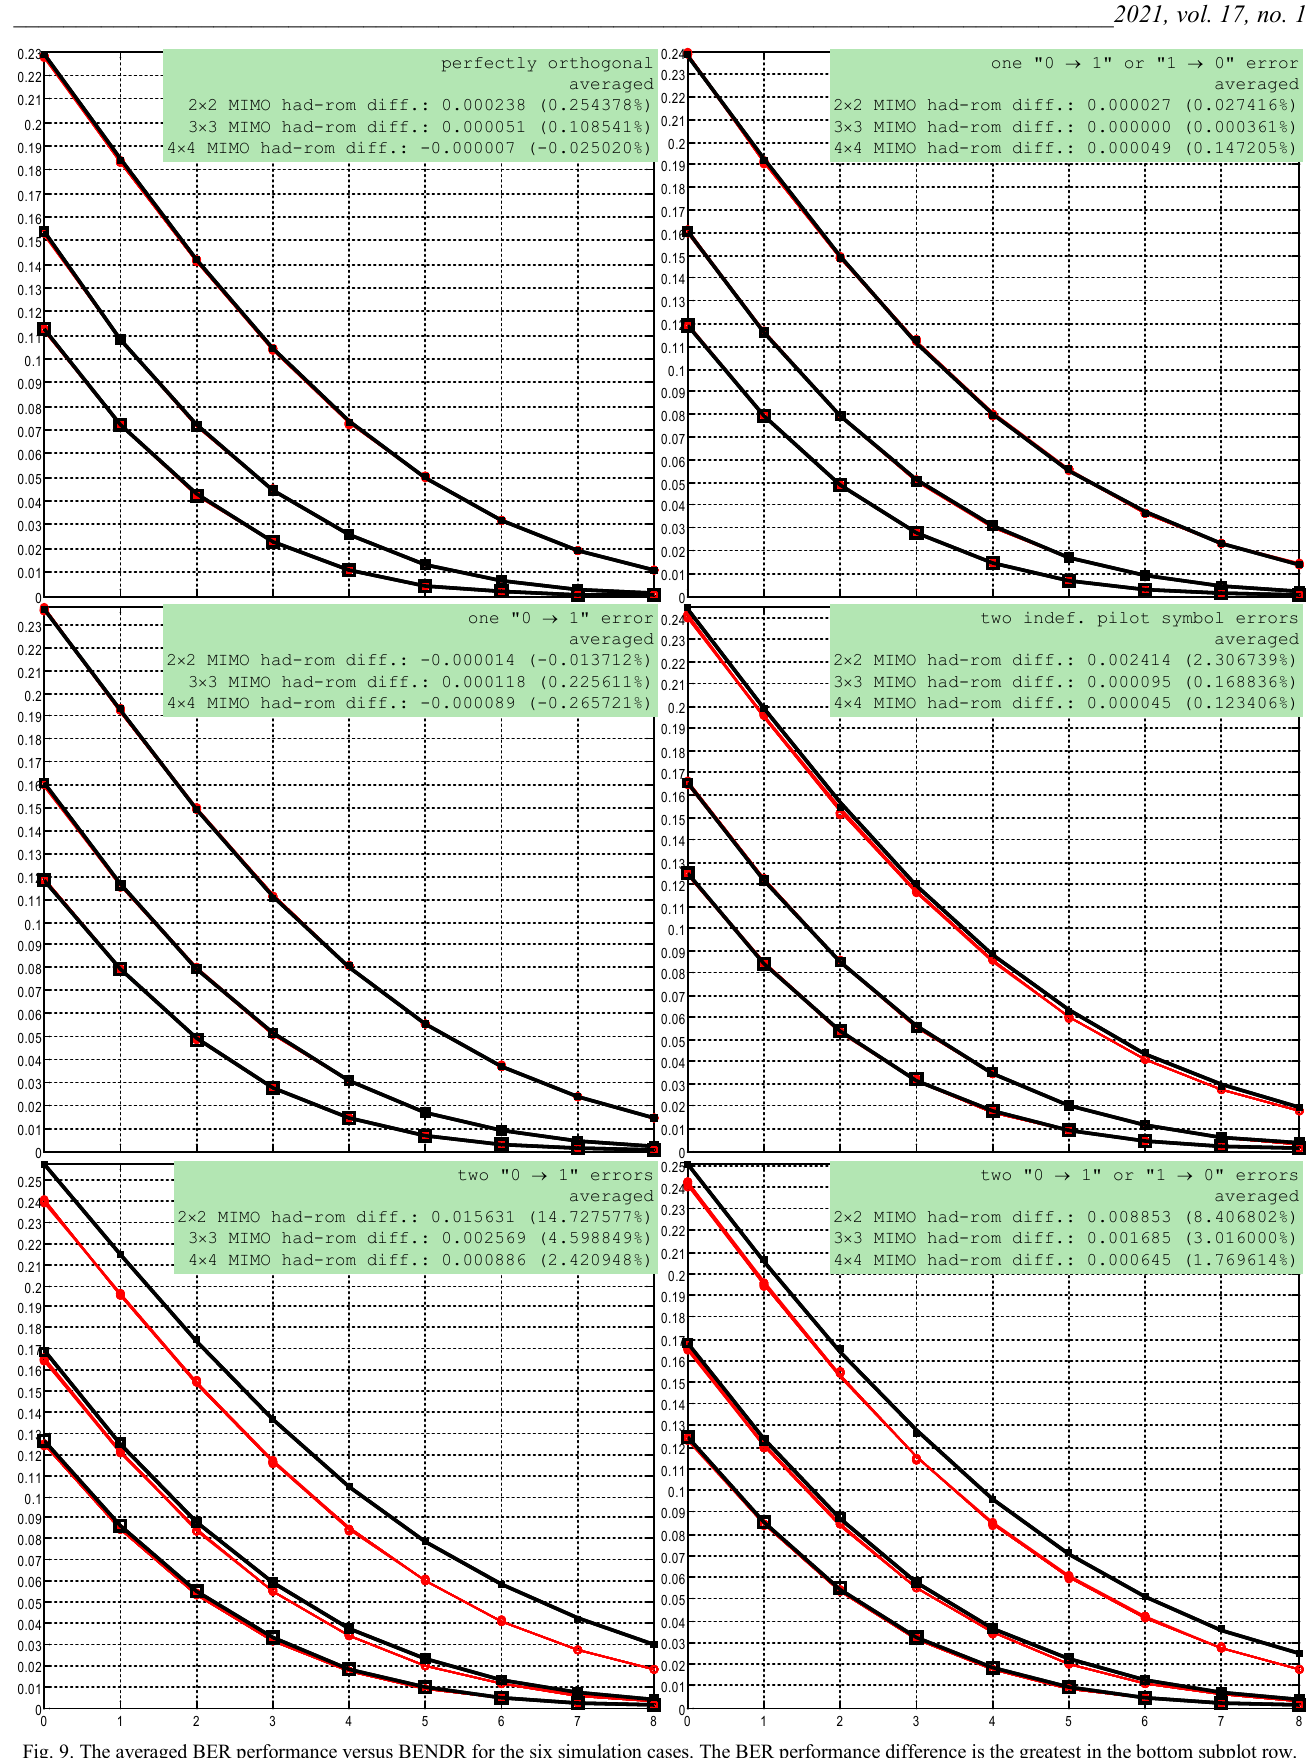
Fig. 9. The averaged BER performance versus BENDR for the six simulation cases. The BER performance difference is the greatest in the bottom subplot row.